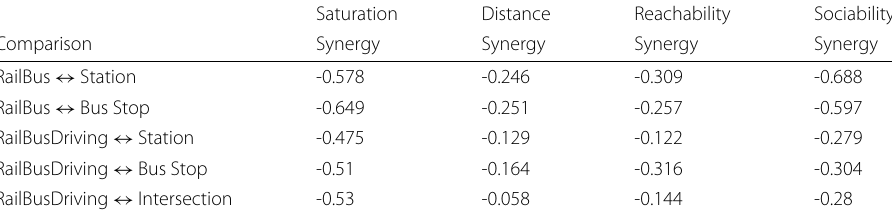
Table 7 Correlation of each synergy score with the distance to each relevant node type